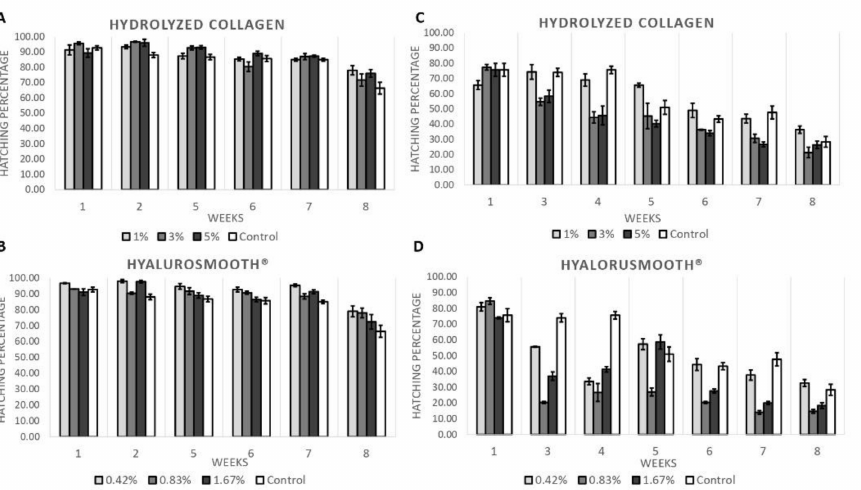
Figure 1. Hatching of Ae. aegypti ( A , B ) and Ae. albopictus ( C , D ) eggs preserved during 8 weeks under storage conditions of 27 ± 1 ◦ C and relative humidity 75 ± 5% with exposition to Hyalurosmooth ® and hydrolyzed collagen with their respective controls under an SIT program in southern